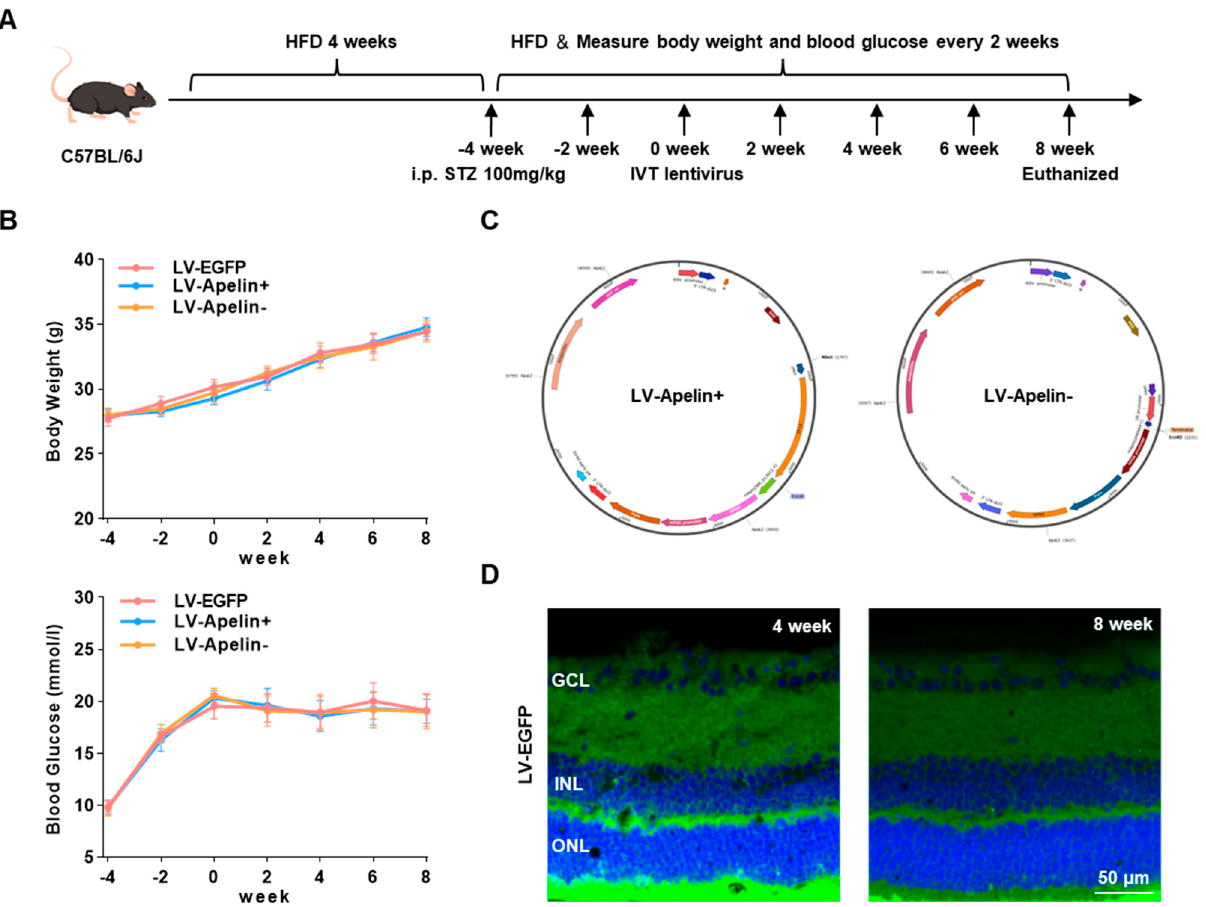
Figure 1. Construction of an HFD/STZ-induced type 2 diabetic mouse model and different lentiviral vectors. ( A ) Experimental and dosing procedures for HFD/STZ-induced type 2 diabetes. ( B ) Body weight and blood glucose were measured every two weeks. Data are expressed as mean ± SD (n = 6). ( C ) The maps of LV-Apelin+ and LV-Apelin − . ( D ) The expression images of LV-EGFP were obtained through confocal laser scanning microscopy (CLSM) at four and eight weeks. Blue: DAPI, green: LV-EGFP. GCL: ganglion cell layer; INL: inner nuclear layer; ONL: outer nuclear